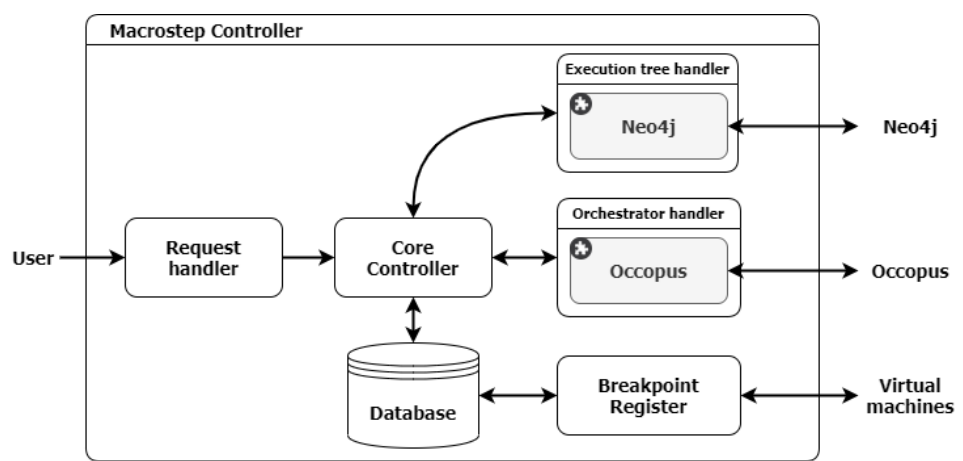
Figure 5. Internal architecture of Macrostep